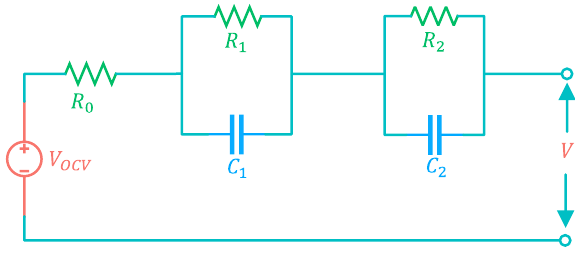
Figure 1. Equivalent circuit cell